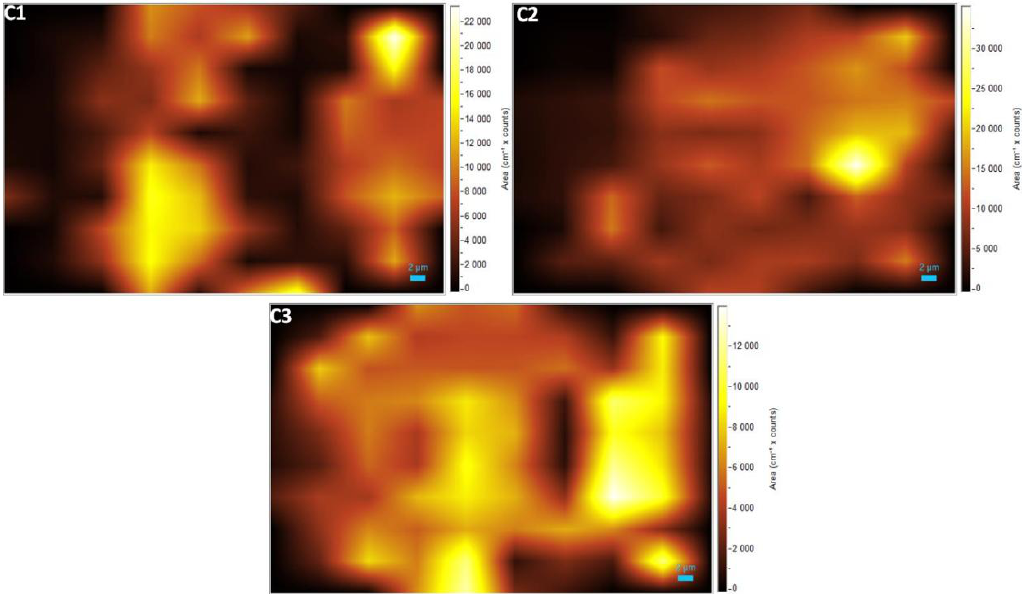
Figure 4. Raman mapping of the samples corresponding to D band.